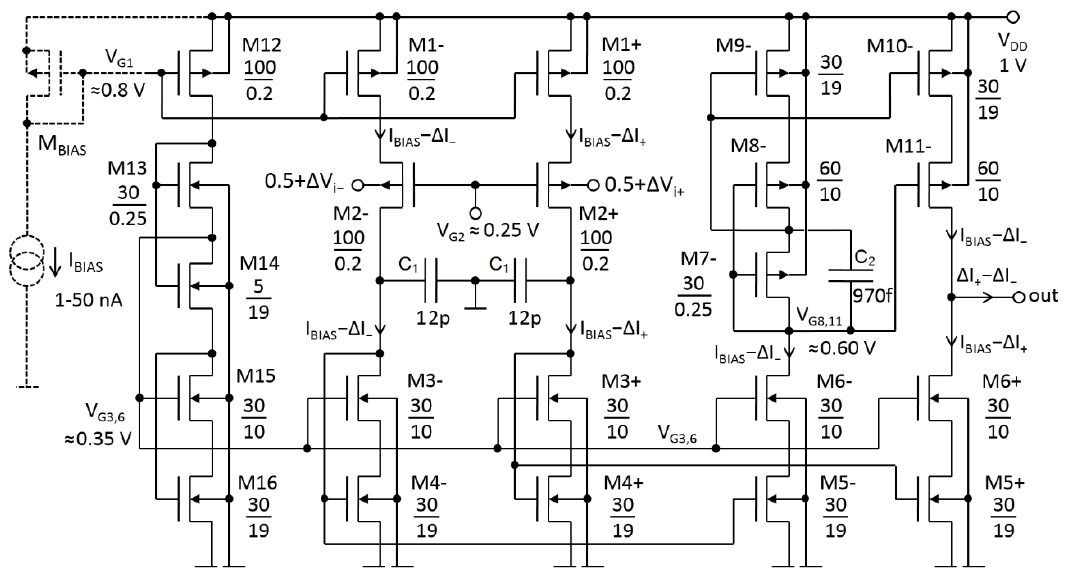
Figure 3. Complete electrical diagram of the low- G m OTA (LTA) prototype. The dashed lines represent an in-chip generator of V G1 .